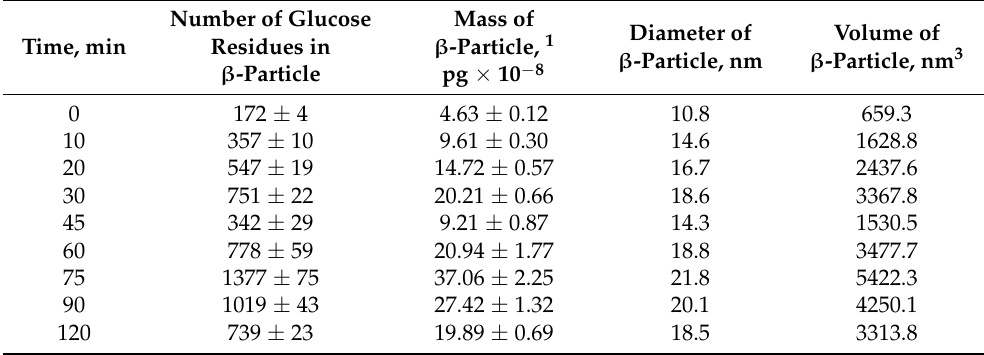
Table 2. Parameters of β -particles at different time intervals after glucose administration to fasting